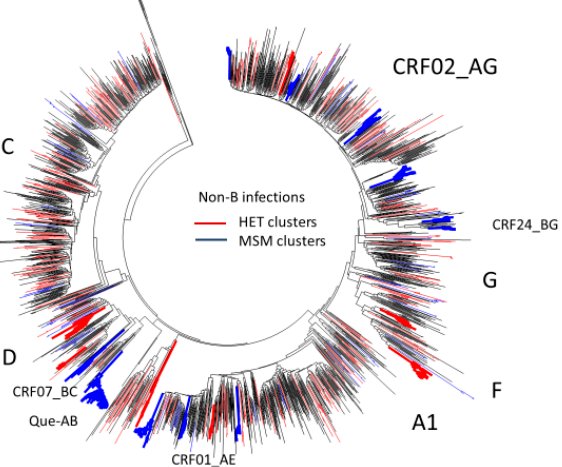
Figure 9. Phylogenetic resolution of the non-B subtype infections in Quebec ( n = 1845). Neighbour- joining tree shows clustering in MSM (blue) and HET (red). Large cluster outbreaks reflect domestic crossover of non-B subtypes amongst MSM, including CRF02_AG, CRF024_BG, CRF01_AE, CRF07_BC, and a novel Quebec A/B founder variant.